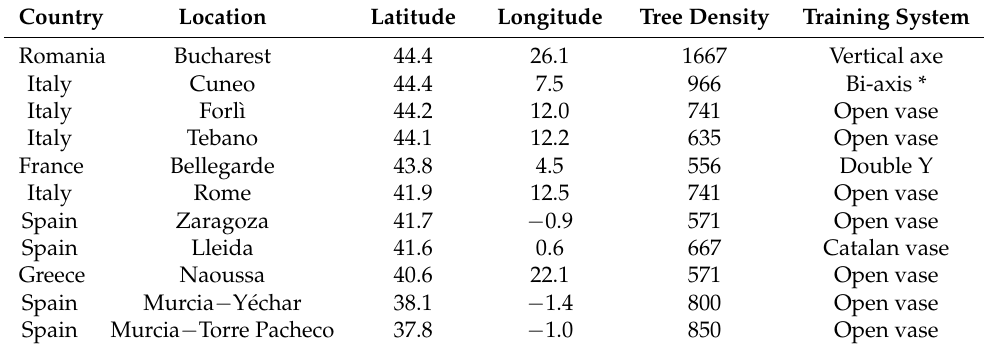
* Hedgerow training system with two primary vertical scaffolds per